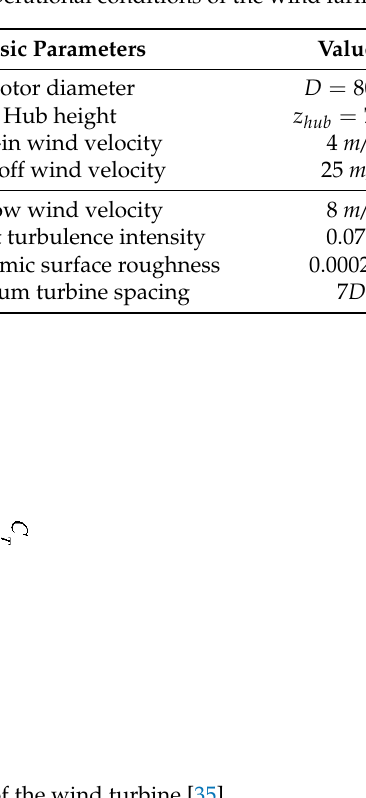
Table 7. Descriptions of basic parameters of measurements and simulations.